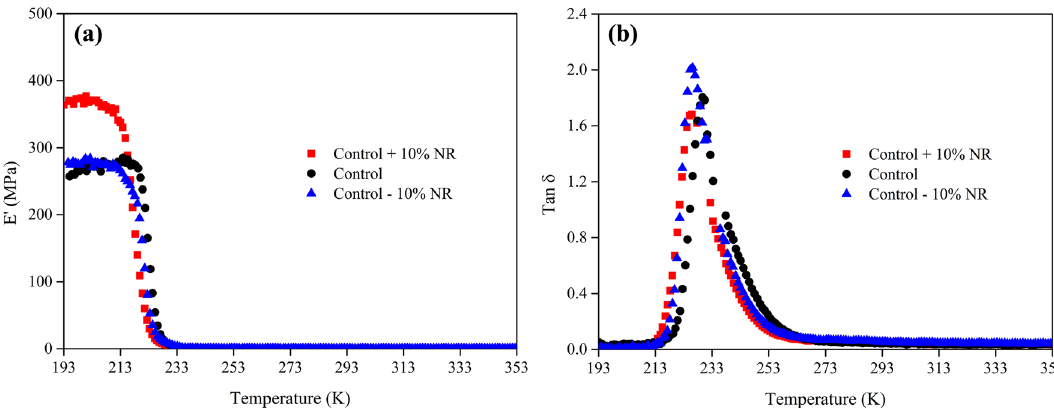
Figure 10. Dynamic mechanical analysis of various foam samples: ( a ) storage modulus, E ’ , as a function of temperature, and ( b ) tan δ as a function of temperature. The relative scatter on the results is estimated equal to about 5%.